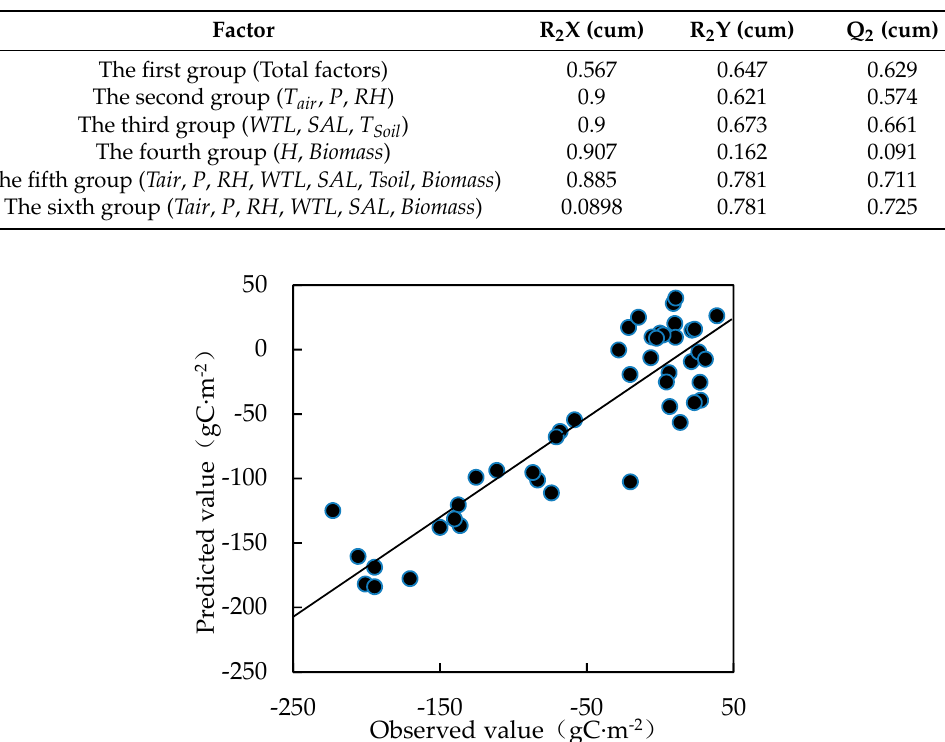
Table 5. Environmental factors that explain the CO 2 amount.